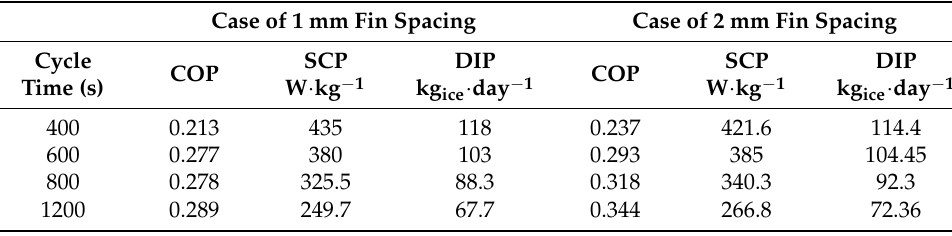
Table 4. The performance indicators of the finned-tube base model at 5 mm fin